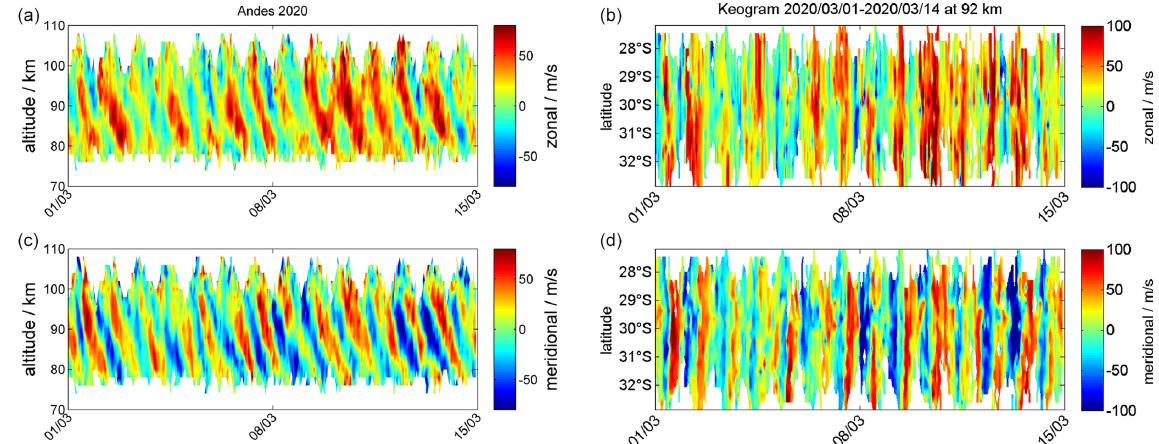
Figure 13. The four panels show a ATW measured with CONDOR and the corresponding keogram for the altitude of 92km. The data were recorded between 1 and 14 March